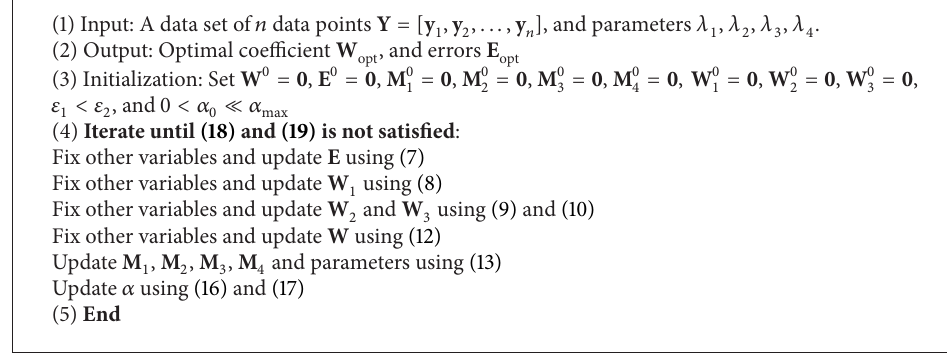
Algorithm 1: The algorithm for low-rank representation-based multitask feature